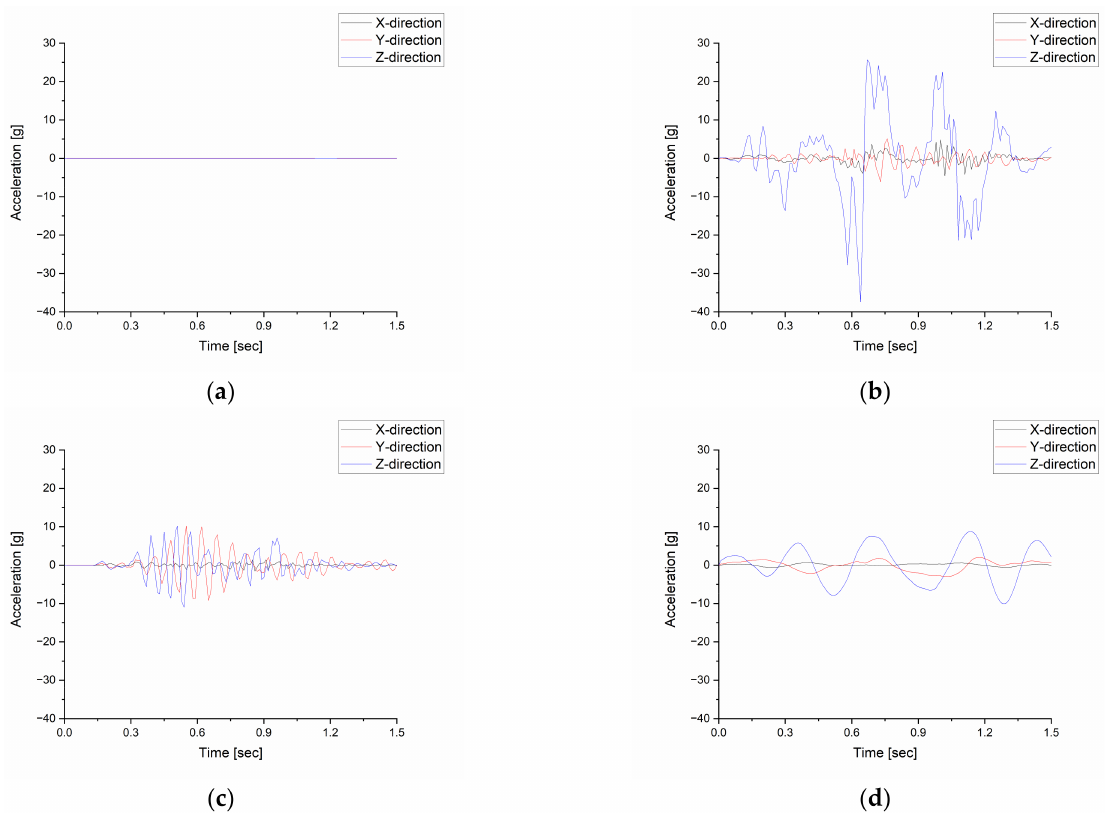
Figure 8. Acceleration calculation results according to time. ( a ) Flat course; ( b ) pothole course; ( c ) short-wave course; ( d ) long-wave